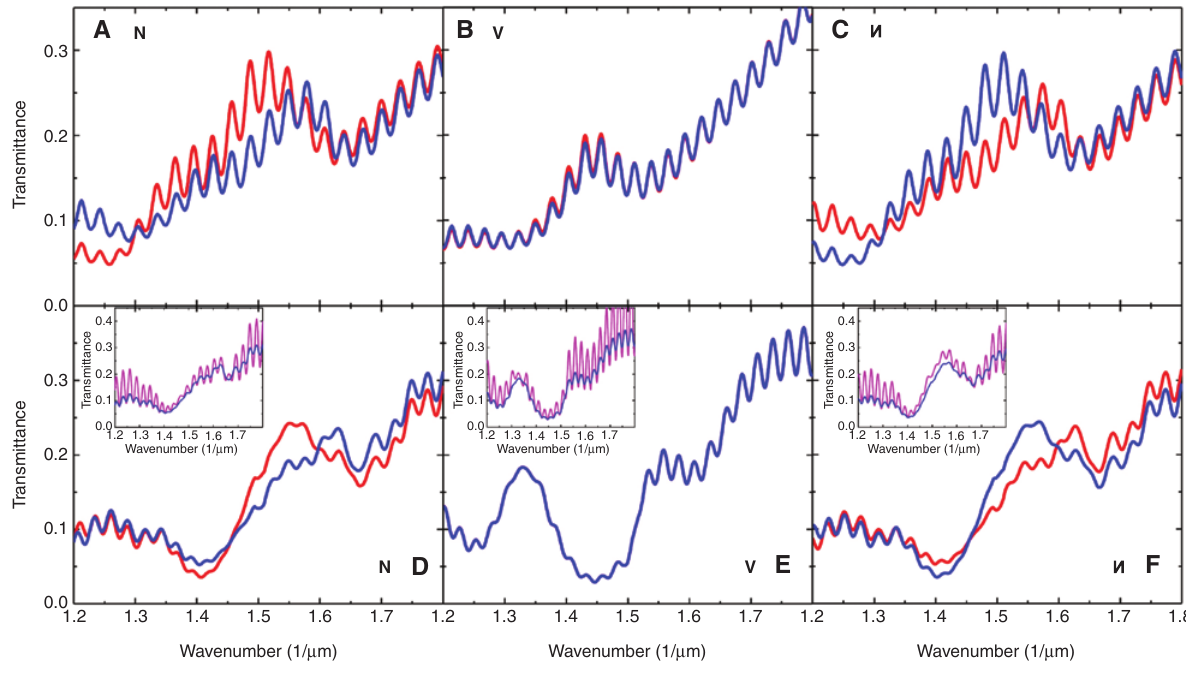
Figure 4: Transmittance of glass-air-metasurface etalon. Transmittance of glass-air-Au sawtooth etalon for LCP (solid red curves) and RCP (solid blue curves) incidence light for (A) N -, (B) V - and (C) И -type complementary Au sawtooth metasurface, respectively. (D)–(F) Corresponding results from CST simulations using r = 0.2 (blue curves) and 1.0 (purple curves) for RCP insets show the transmittance calculated using r G